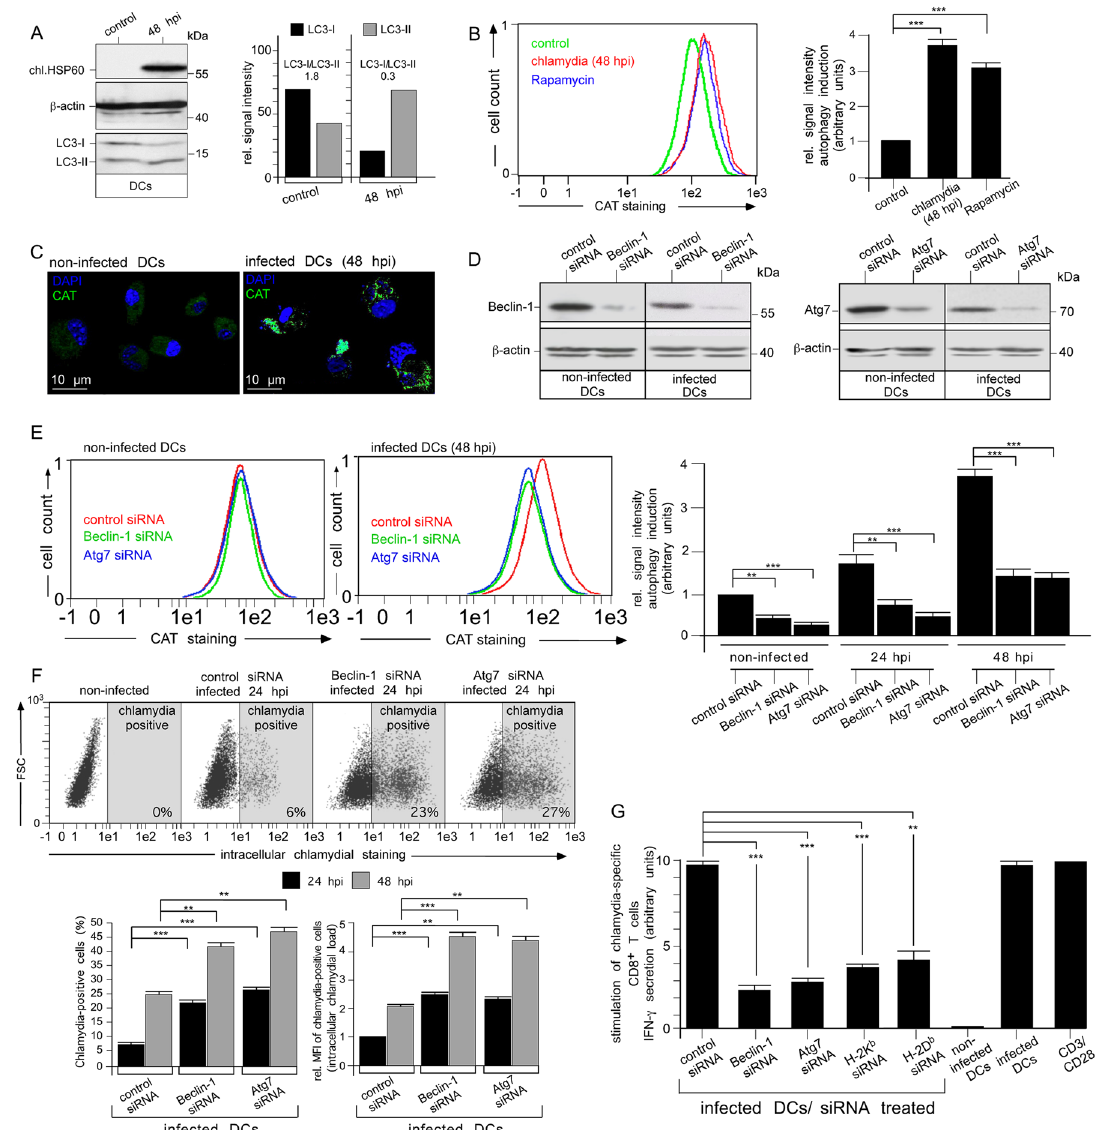
Figure 1. Enhanced autophagy in chlamydia-infected DCs is critical for intracellular degradation and MHC I-presentation of bacteria. ( A ) Chlamydia-infected DCs were analysed in Western blots using antibodies against chlamydial (chl.) HSP60, LC3, and β -actin (left). The LC3-I:LC3-II ratio was determined by densitometric scanning (right panel). ( B , C ) Autophagosome formation in DCs was analysed using CytoID labelling (fluorescent cationic amphiphilic tracer CAT) monitored with flow cytometry (left and right, Rapamycin was used as autophagy inducer) ( B ) or fluorescence microscopy (CAT is shown in green, DAPI in blue) ( C ). ( D ) Western blot analysis of infected (48 hpi) and non-infected DCs silenced for Beclin-1 and Atg7. ( E ) Beclin-1- and Atg7-silenced DCs as well as control cells were infected or not and analysed by CytoID staining. The left and middle panel show representative flow cytometry experiments of non-infected and infected (48 hpi) DCs. Data from three independent experiments (non-infected, 24 and 48 hpi) are summarised as bar graphs with arbitrary units (right). Data in ( B and E ) were normalised such that the value obtained for non-infected cells (control siRNA in ( E ) was set to 1. ( F ) Beclin-1- and Atg7-silenced DCs were infected or not with chlamydia and analysed by flow cytometry using the IMAGEN kit. The upper panel shows a representative analysis at 24 hpi. Data from three independent experiments (24 and 48 hpi) are summarised in bar graphs (lower panel). The number of chlamydia-positive cells was measured, as well as the bacterial load (MFI) of infected cells. MFIs obtained for infected cells (24 hpi) were set to 1 arbitrary unit. ( G ) DCs were siRNA-silenced for Beclin-1 and Atg7, MHC I (H-2K b and H-2D b ) and then infected with chlamydia. AllStars siRNA, non-infected cells and anti-CD3/CD28-beads were used in control experiments. DCs were cocultured with chlamydia-sensitised CD8 + T cells. IFN- γ secreted by CD8 + T cells was assayed by ELISA. Relative values of IFN- γ secretion are expressed in arbitrary units (maximum value was set to 10) and are means ± SD of three independent experiments. Statistical analysis in ( B , E , F , G ) was performed as described in Methods ( ** p < 0.01; *** p < 0.001 versus controls; n =